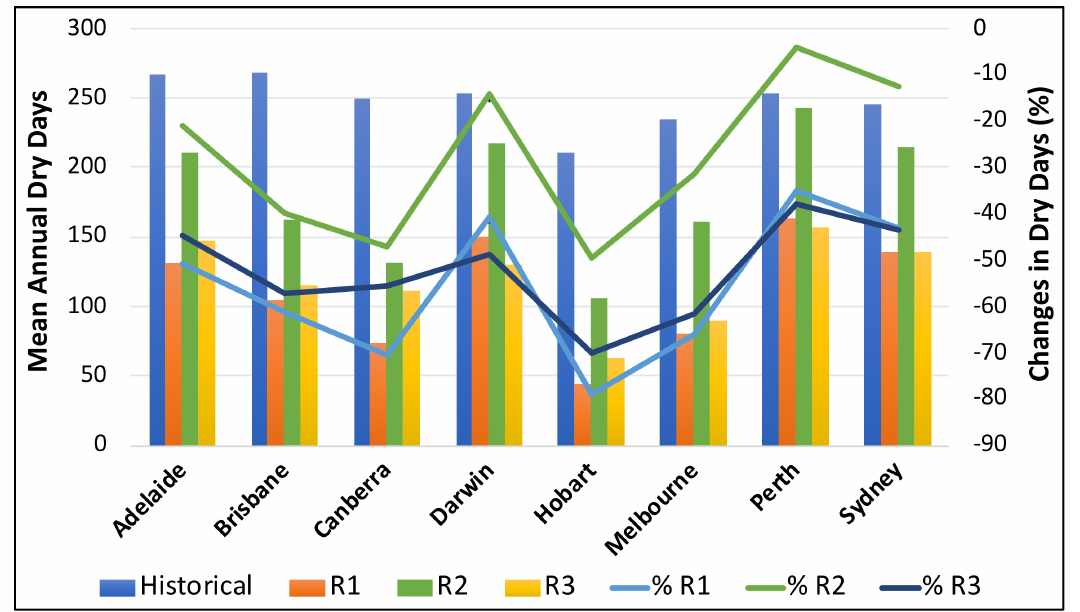
Figure 5. Average annual dry days and percentage changes between the future period (2022–2039) and historical data.